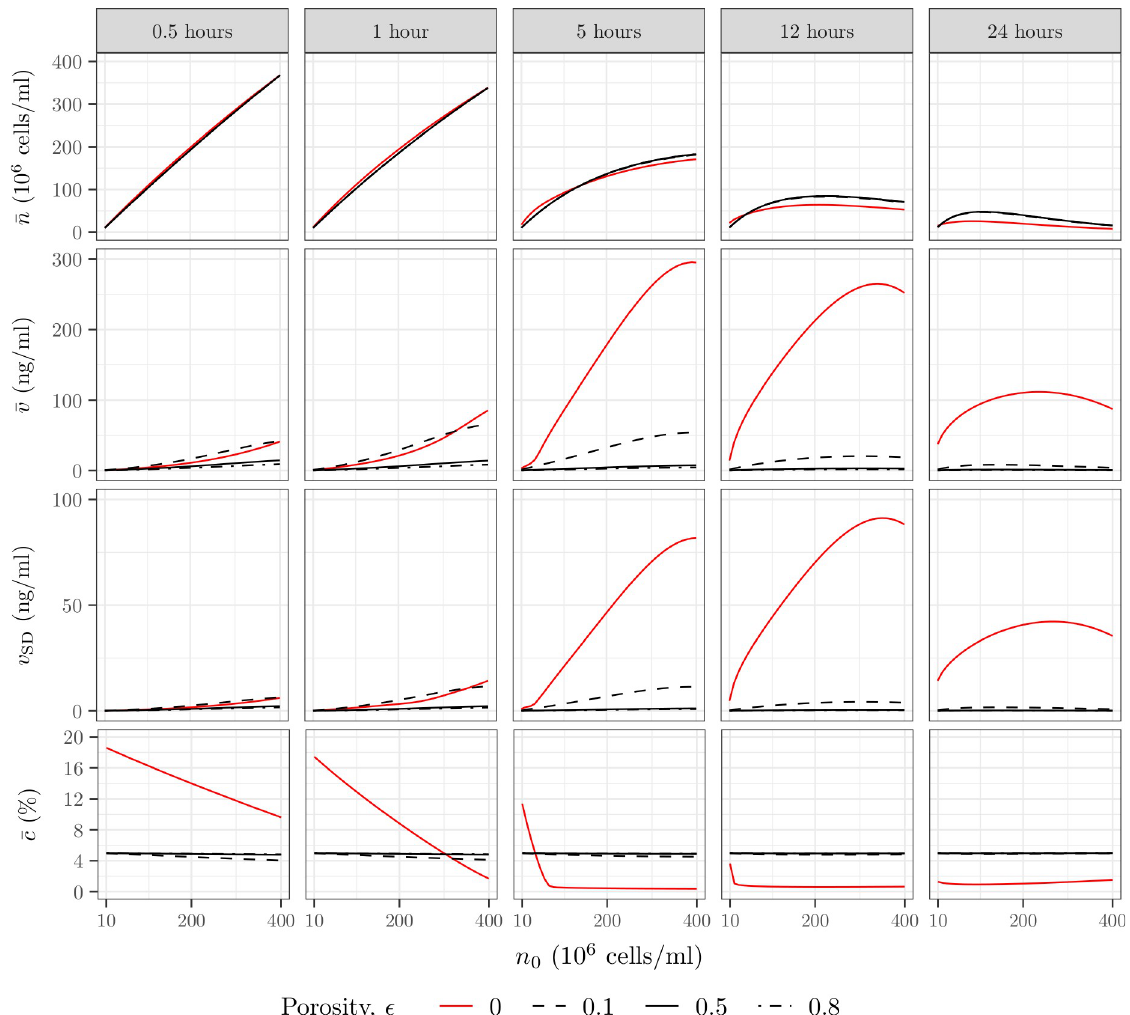
Fig 7. Increasing the sheath porosity of a permeable construct results in a higher cell density and oxygen concentration and a much lower VEGF concentration and gradient after 24h. Mean cell density � n � , mean oxygen concentration � c � , mean VEGF concentration � v � and standard deviation v SD , as functions of the initial cell density n 0 , for different sheath porosity � , at different time points. The porous sheath structure is approximated by an array of overlapping sphere (see Table 1) with a thickness T = 0.25mm. We note that � = 0 corresponds to an impermeable sheath (red